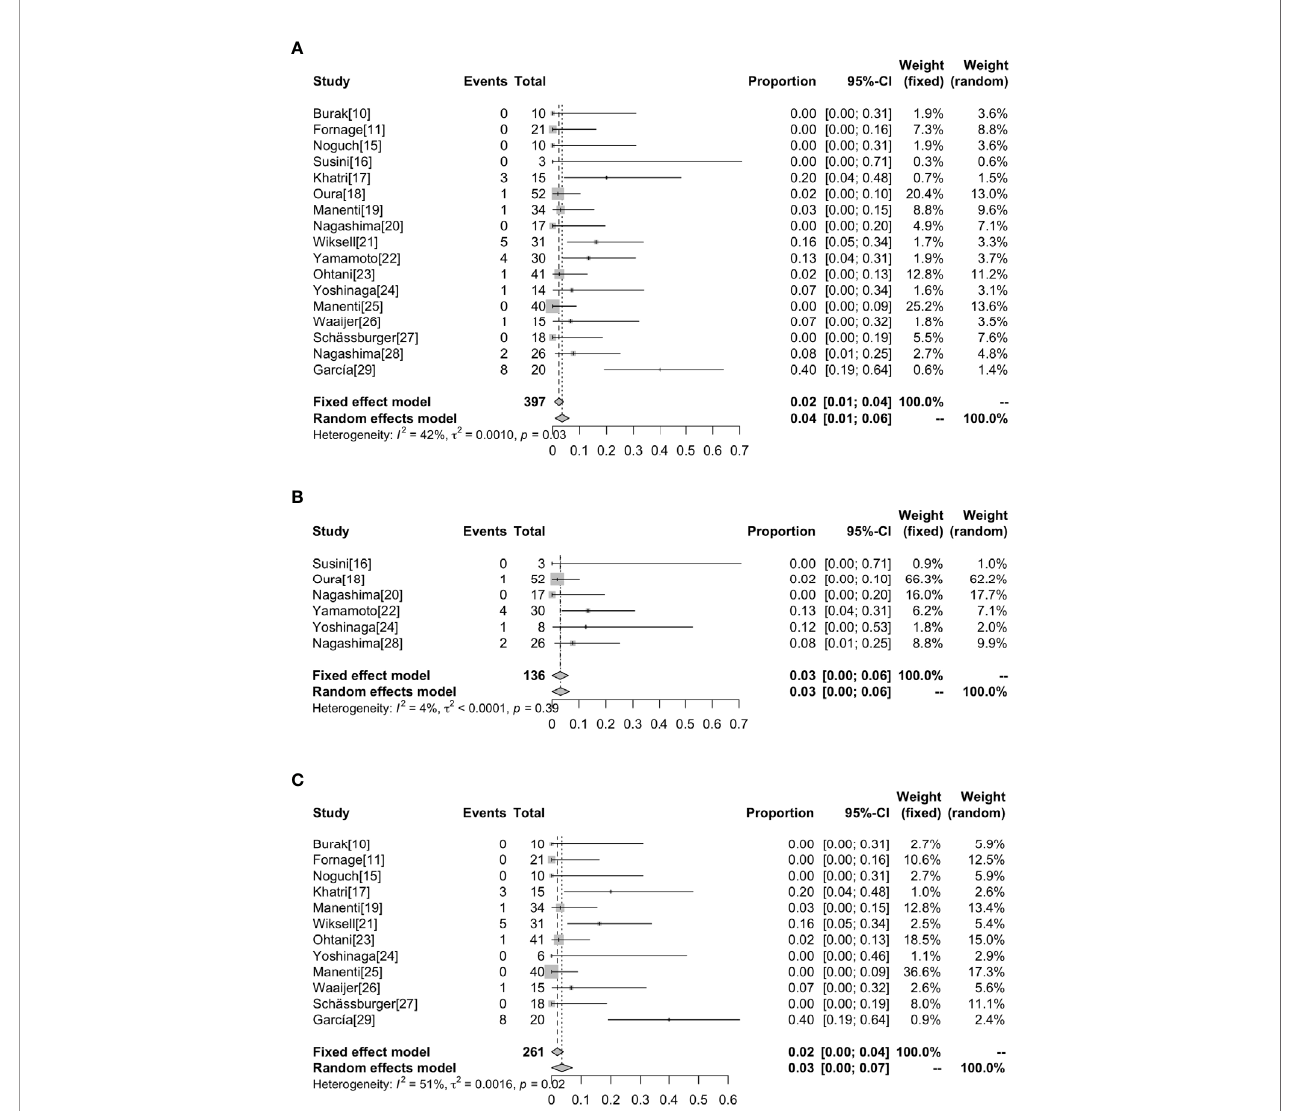
FIGURE 5 | Forest plot showing the analysis of complications rate in patients receiving RFA. The results of all the patients (A) , patients without surgical resection following RFA (B) , patients with surgical resection following RFA (C) are shown,